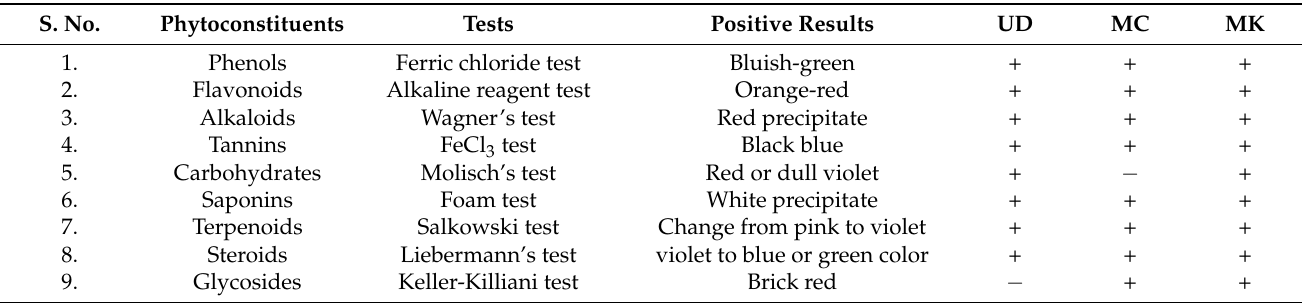
Table 4. Preliminary qualitative screening of secondary metabolites of crude extracts of UD, MC, and